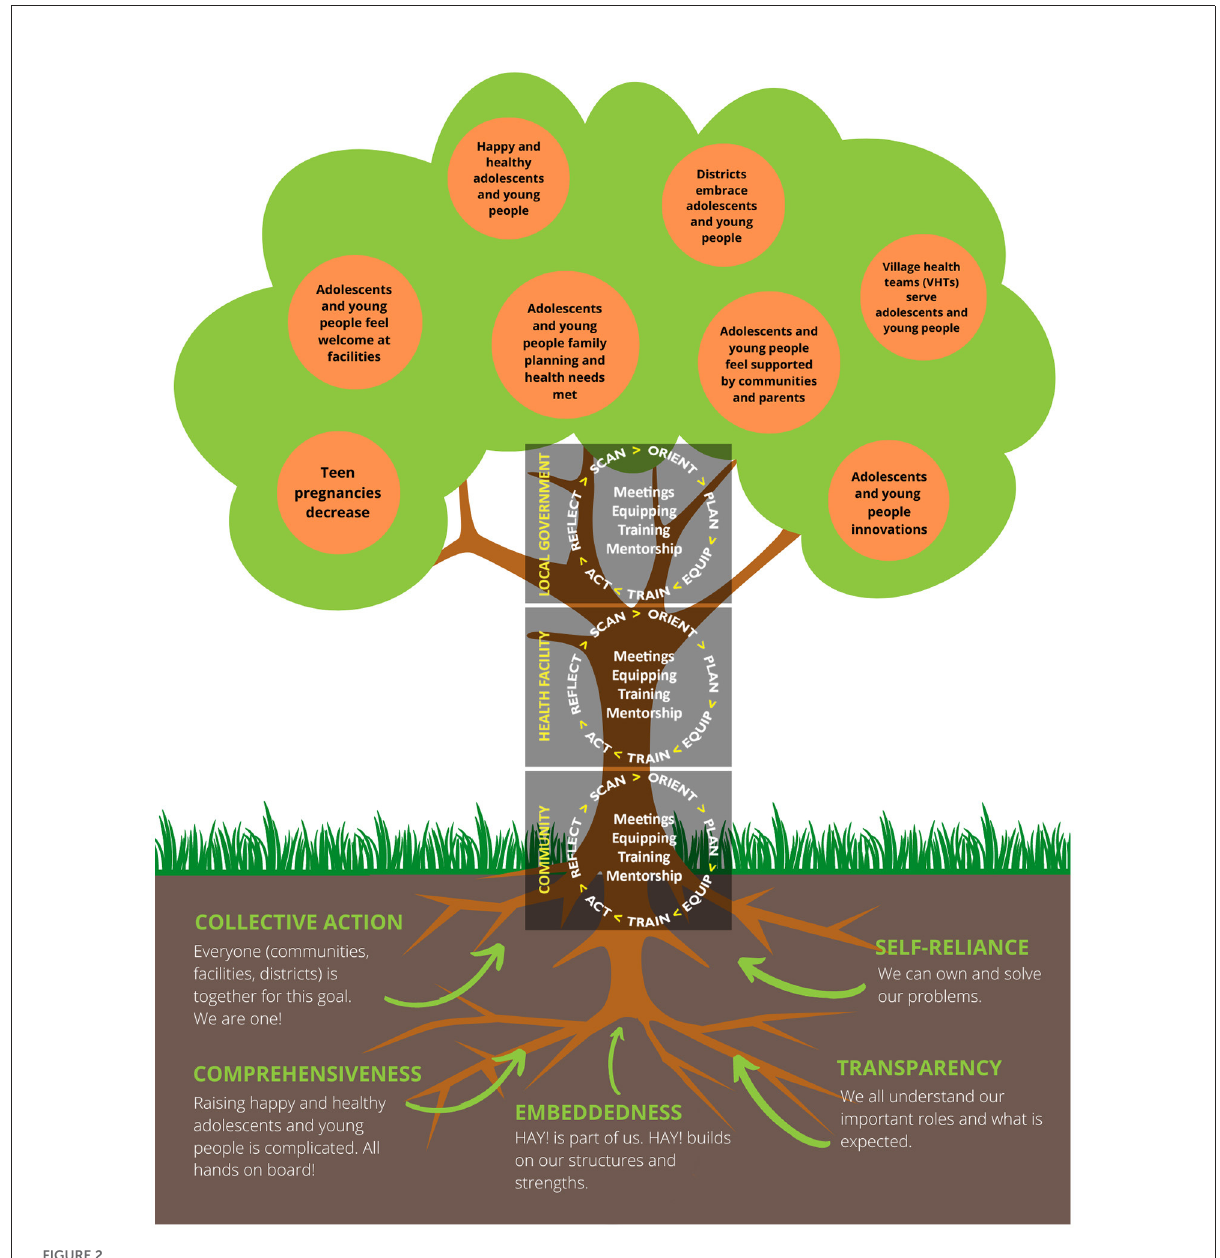
FIGURE2 MERI Approach tree (community